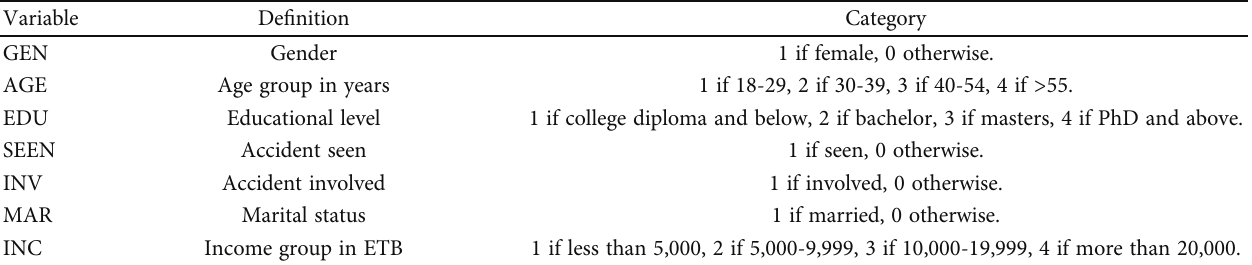
Table 4: Description of variables (source: authors).